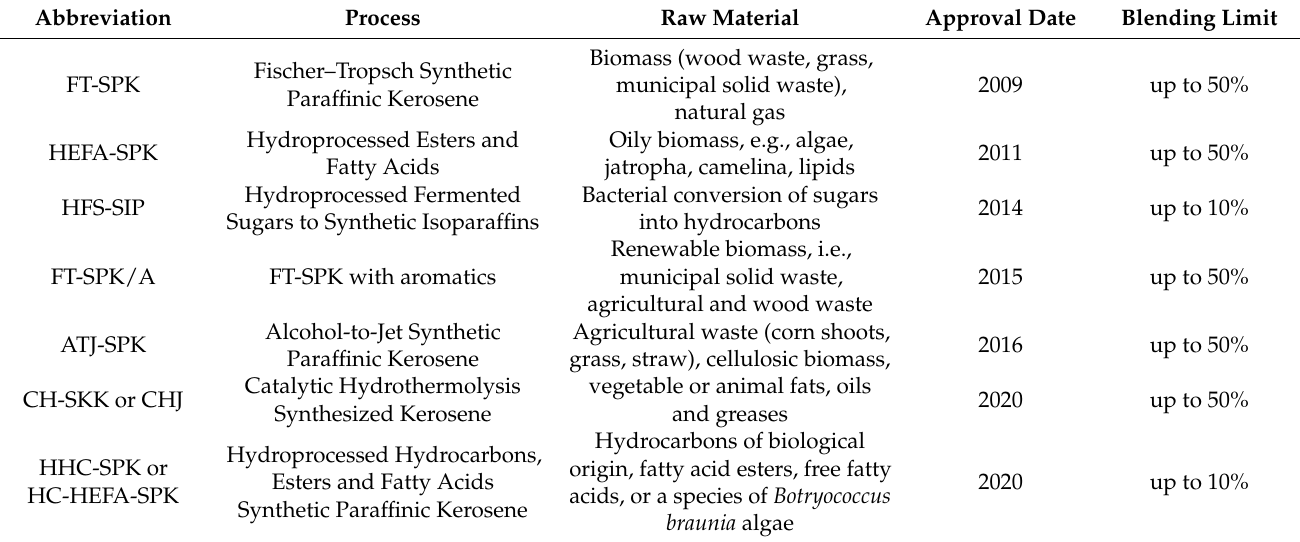
Table 1. Methods of producing alternative fuels approved by the ASTM D7566 standard